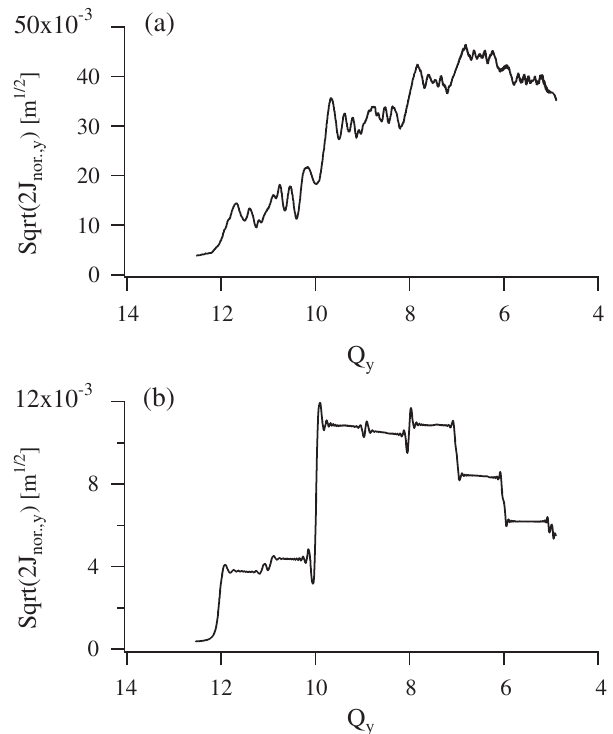
FIG. 2. Examples of single particle normalized amplitude evo- lution when alignment errors are included: (a) 100 turns to finish the whole cycle, (b) 1000 turns to finish the whole cycle. Note that the magnitude of misalignment in 100 turns acceleration is larger so that the maximum amplitude is larger in (a) than that in (b).